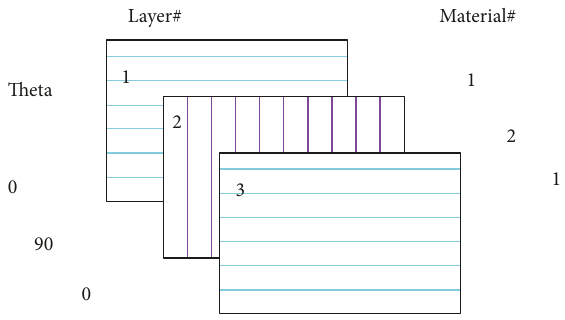
Figure 2: Layer parameters of laminated